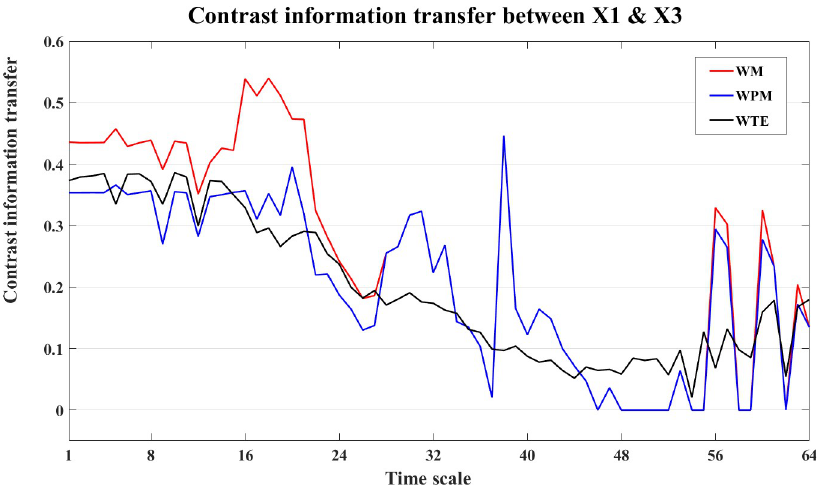
Fig 14. The contrast information transfer values for the nonlinear interaction X1- > X3. The three curves show the contrast WM (red), WPM (blue) and WTE (black) information transfer between X1 and X3 at different time scales s (i = 1,2, ... 64). All three measures indicate the correct nonlinear interaction from X1- > X3.